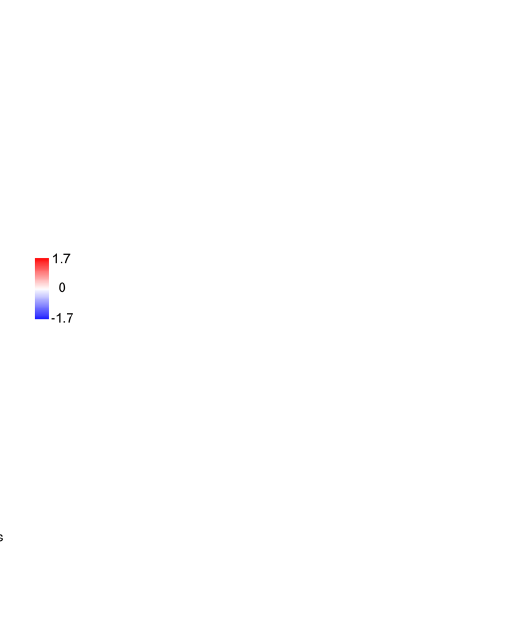
Figure 8. A heat map for predicting the functional contribution of fungi in soils with different treat- ments based on FUNGuild. (Colors from blue to red represent the relative abundance of the func- tions from low to high). 3.10. Relationship between Soil Bacterial Community Structure and Soil Chemical Properties